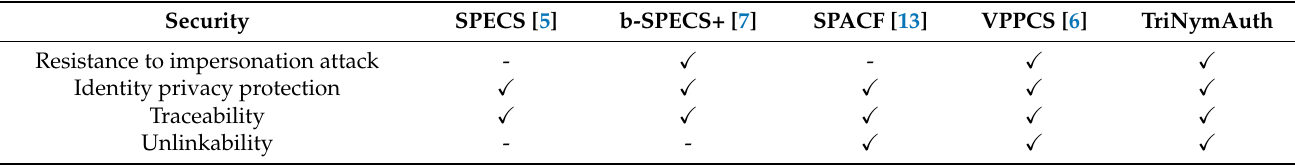
Table 2. Security and privacy comparison.